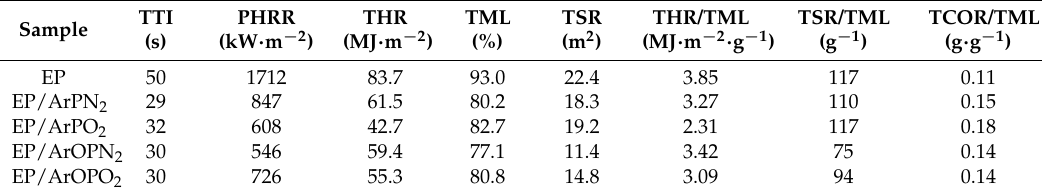
Table 3. Cone calorimetric data for EP and EP/polysulfone composites at 50 kW · m − 2